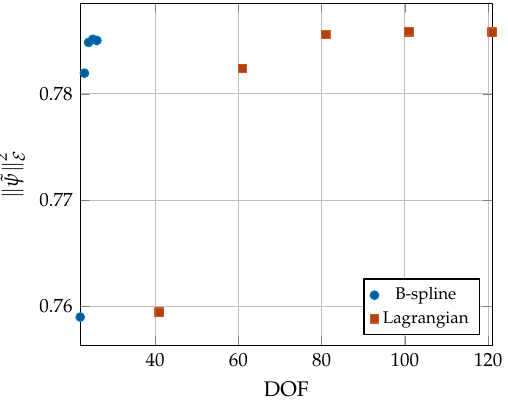
Figure 20. Squared space-time energy norm (60) of IGA-Energetic BEM (left) and standard Energetic BEM (right) approximate solutions, for increasing degree d versus the number of DOFs.